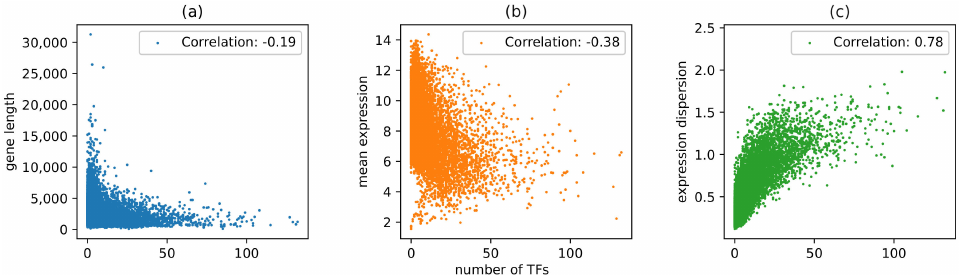
Figure 4. Correlation among gene length, number of TF, average expression, and their dispersion of expression. ( a ) Gene length negatively correlates with the number of predicted regulators, | in j | . ( b ) Mean expression has a negative correlation with | in j | . ( c ) Expression dispersion and | in j | positively